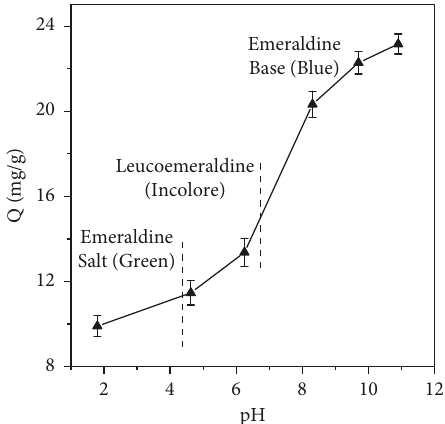
Figure 8: Effect of the solution pH on the MB adsorption capacity of